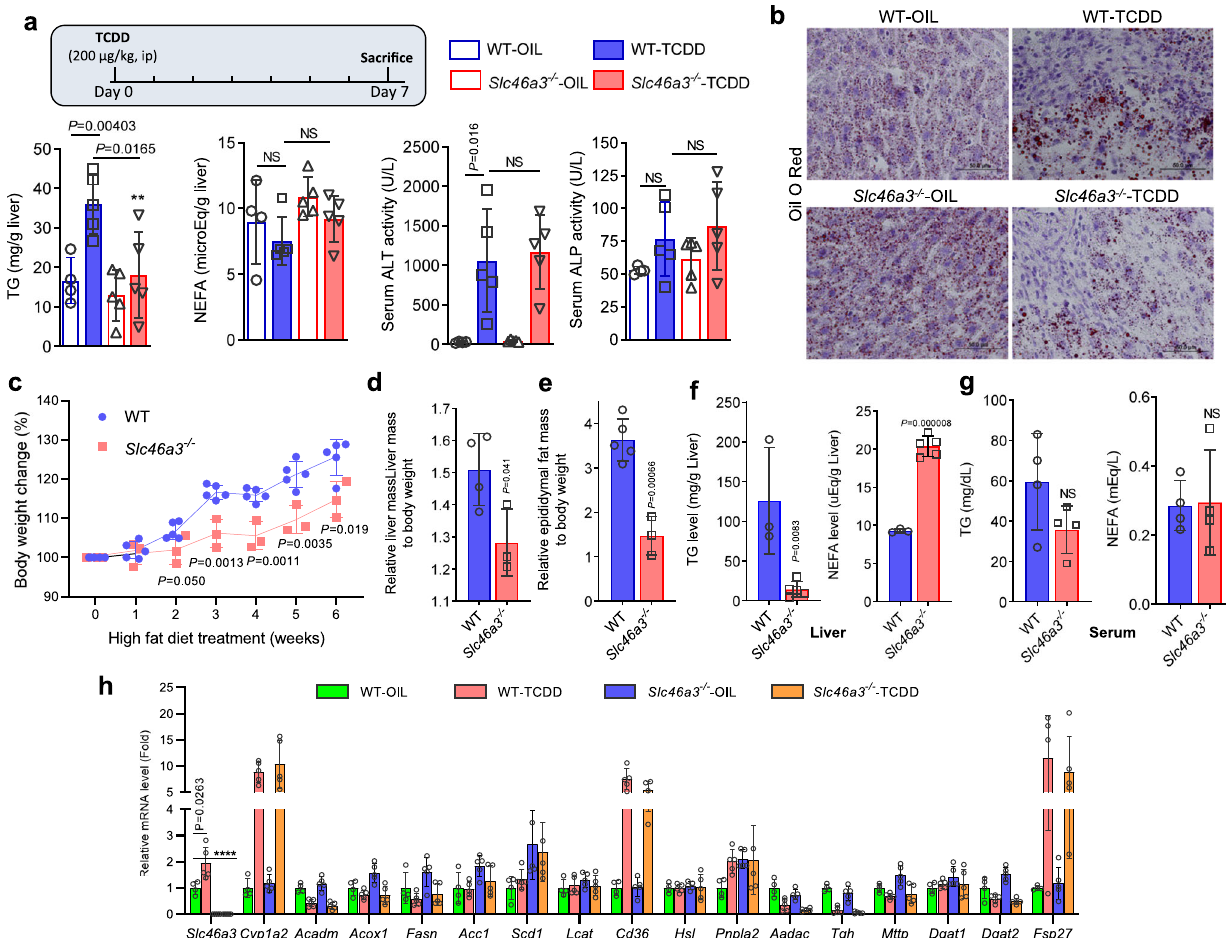
Fig. 6 TCDD induces accumulation of hepatic triglyceride through SLC46A3. a Measurements of hepatic triglyceride (TG) and non-esteri fi ed fatty acid (NEFA) as well as serum ALT activity and serum ALP activity ( n = 4 for WT-OIL group; n = 5 for other groups). Two-way ANOVA with Bonferroni ’ s multiple comparisons test, ** p = 0.0062; NS not signi fi cant. b Representative Oil O Red staining of liver tissue. c Body weight changes after high-fat diet WT ( n = 4 per group) and Slc46a3 − / − ( n = 3 per group) mice. d Liver mass to body weight after high-fat diet in WT ( n = 4 per group) and Slc46a3 − / − ( n = 3 per group) mice. e Epididymal fat mass after high-fat diet in WT ( n = 5 per group) and Slc46a3 − / − ( n = 3 per group) mice. f Hepatic TG and NEFA levels after high-fat diet in WT ( n = 3 per group) and Slc46a3 − / − ( n = 5 per group) mice. g TG and NEFA levels in the serum after high-fat diet in WT ( n = 4 per group) and Slc46a3 − / − ( n = 4 per group) mice. NS not signi fi cant. h Hepatic mRNA expressions of lipid-related metabolizing genes by oil or TCDD (10 µ g/kg for 24h) in WT and Slc46a3 − / − mice. Two-way ANOVA with Bonferroni ’ s multiple comparisons test, **** p <0.0001. The sample sizes of WT-OIL, WT-TCDD Slc46a3 − / − -OIL, and Slc46a3 − / − -TCDD are n = 4, 5, 5, 5 mice per group, respectively. Each data point represents the mean ± SD and the adjusted p value, presented in the panels, was determined by unpaired two-tailed Student ’ s t test using indicated sample sizes and